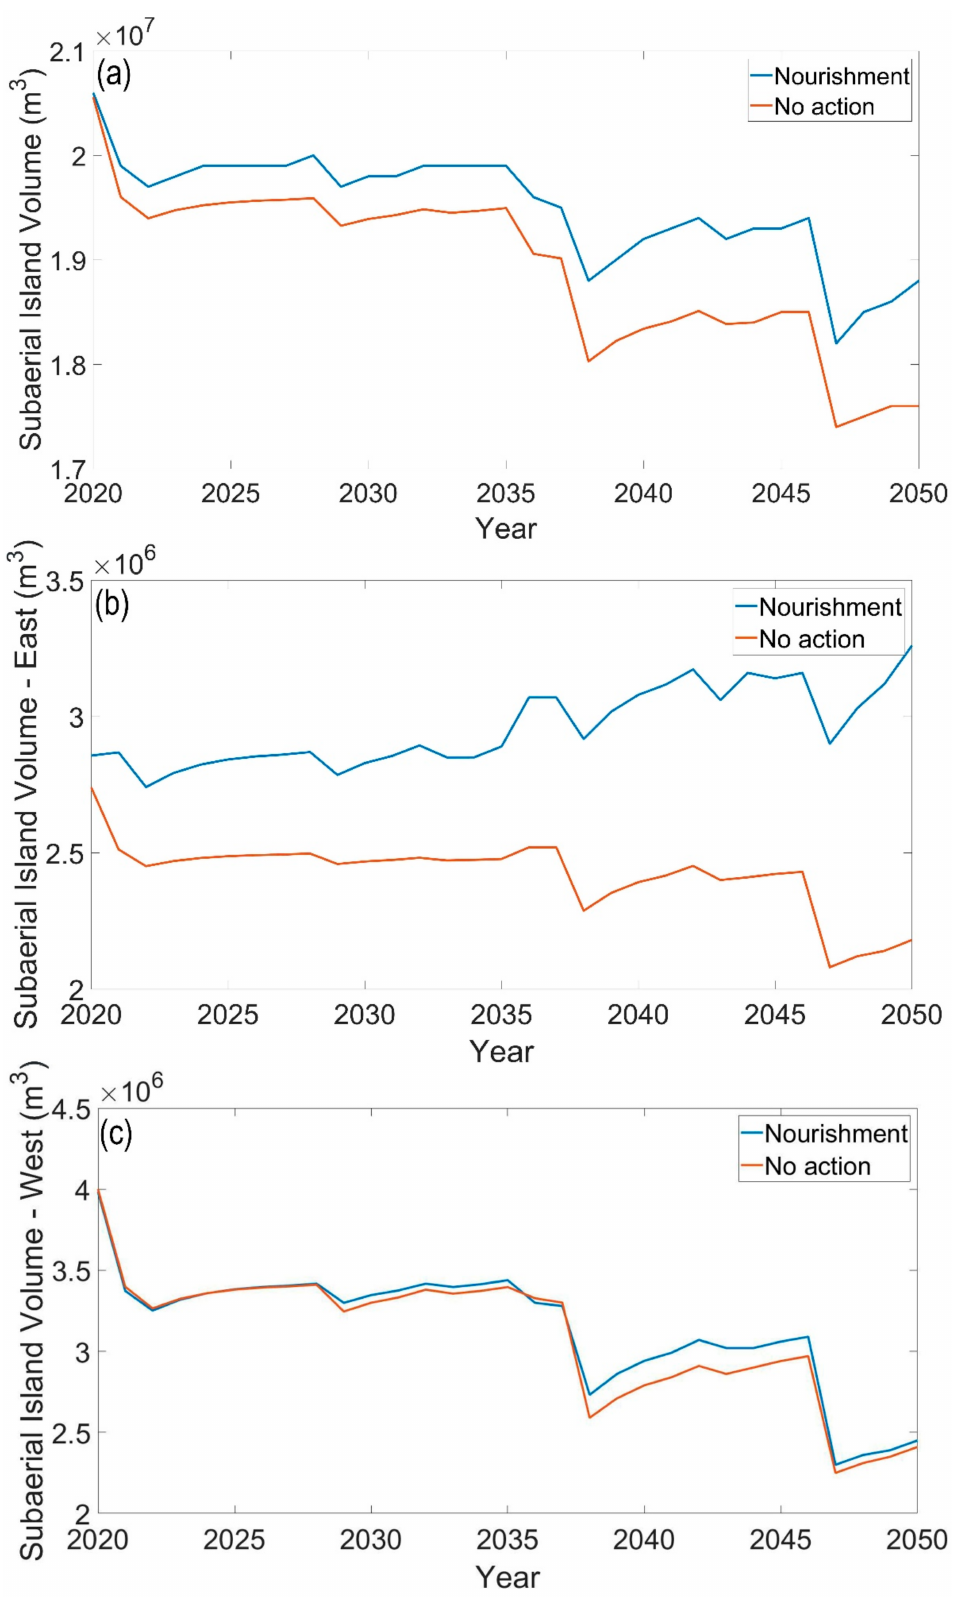
Figure 3. Subaerial island volume through the 30-year simulation across ( a ) the entire island and ( b ) east of Katrina Cut and ( c ) west of Katrina Cut under scenarios of nourishment and